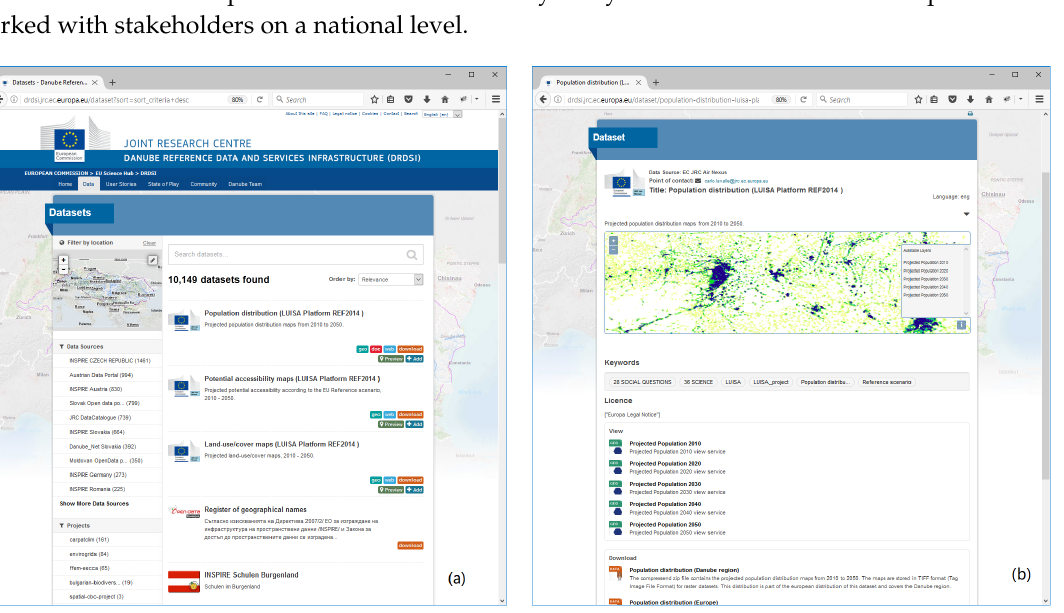
Figure 2. User interface of DRDSI. List of available datasets ( a ) and details about one particular entry ( b ). Source: